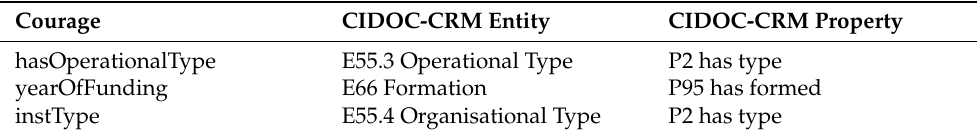
Table 2. COURAGE organization entity representation in CIDOC-CRM.